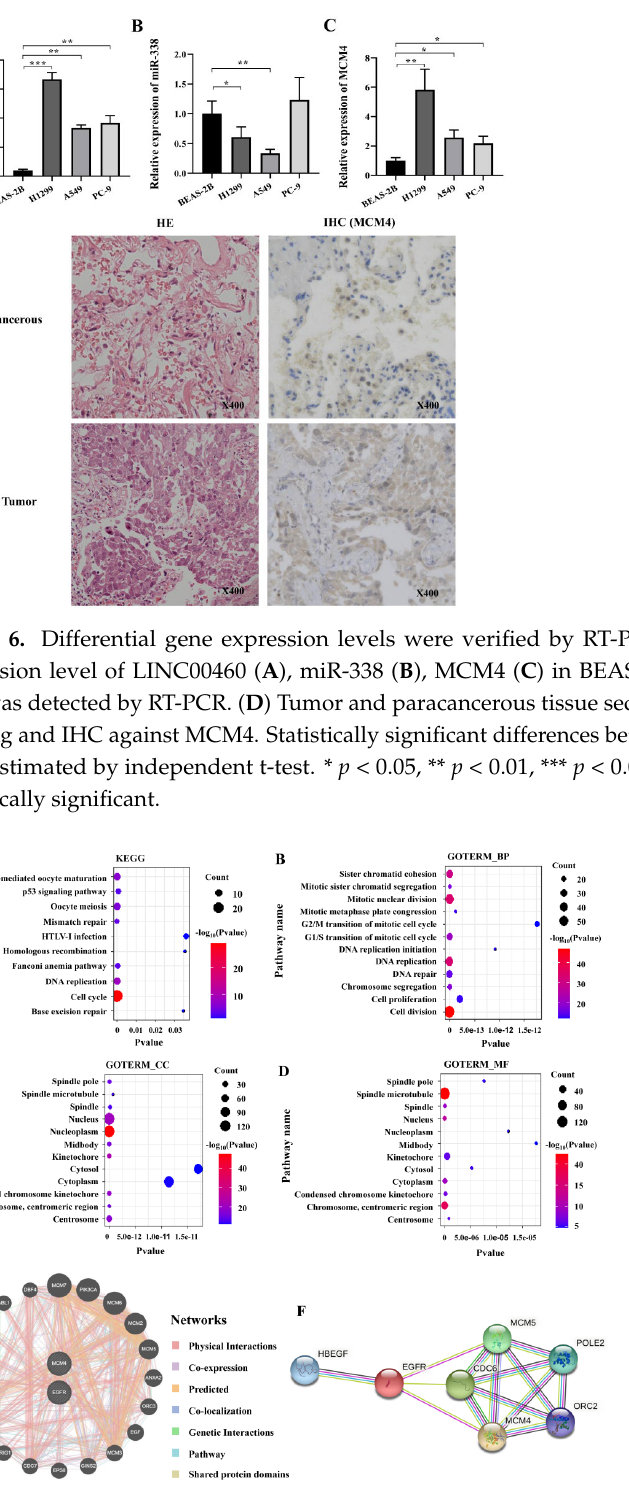
Figure 7. Functional enrichment analysis of MCM4-related genes in LUAD as well as the interaction network between MCM4 and EGFR. ( A ) KEGG, ( B ) biological process (BP), ( C ) cellular component (CC), ( D ) molecular function (MF), ( E ) the gene interaction network between MCM4 and EGFR, ( F ) the protein interaction network between MCM4 and EGFR.